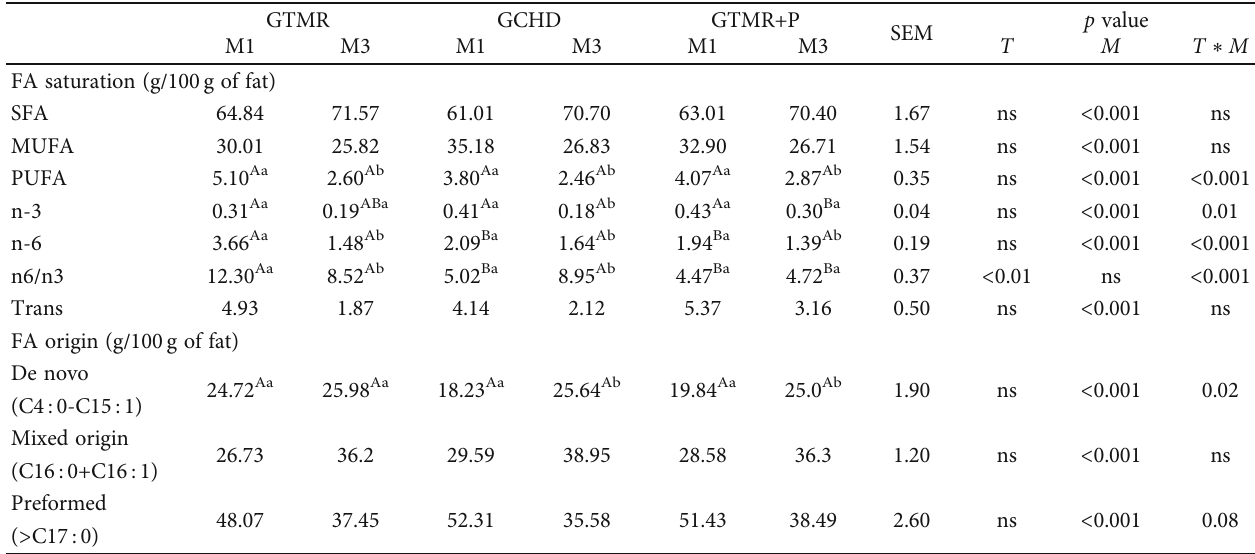
Table 3: E ff ect of treatment ( T ), month ( M ), and interaction between treatment and month ( T ∗ M ) on fatty acid pro fi le (FAP) in month 1 (M1) and month 3 (M3) of lactation.